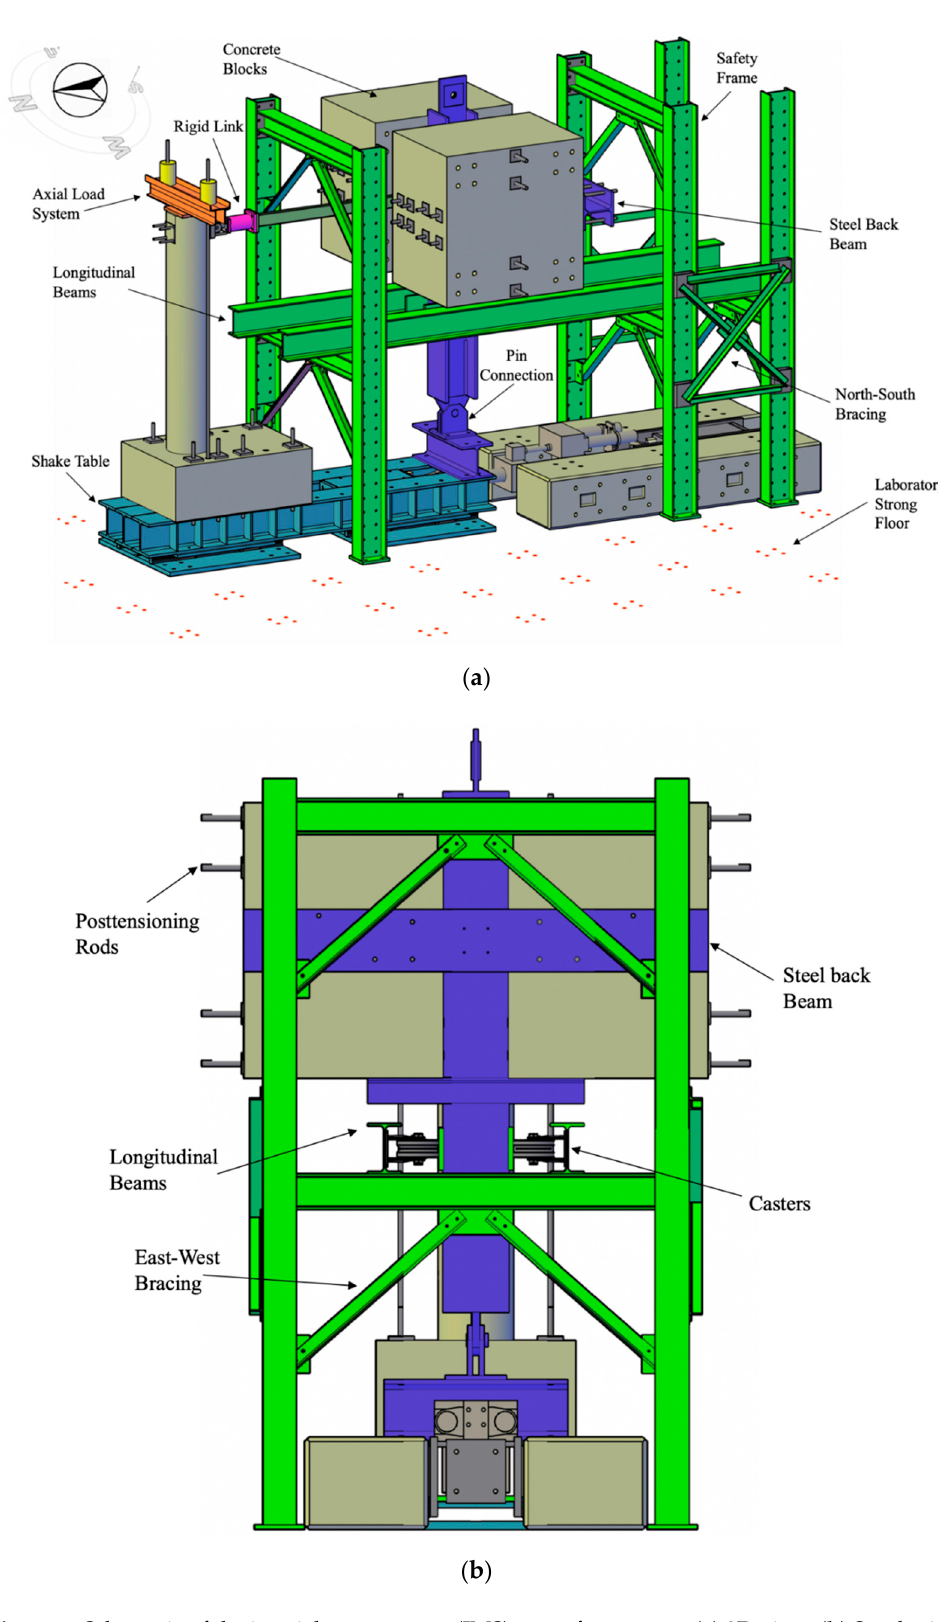
Figure 5. Schematic of the inertial mass system (IMS) part of test setup: ( a ) 3D view; ( b ) South view. Since the IMS was composed of only a steel column and concrete masses, the setting process of an RC specimen can be completed in a short time. As illustrated in Figure 6, the